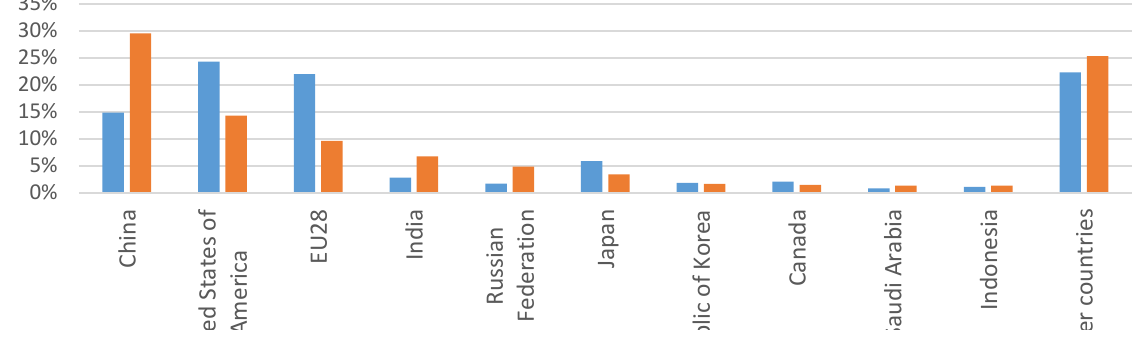
Figure 2. Comparison of the share of CO2 and GDP in the world by countries